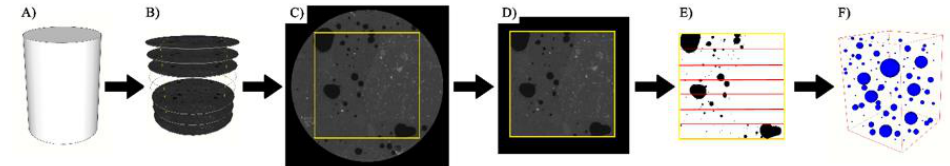
Figure 4. Approach 1: Downsized linear traversed method (2D). ( A ) Extracted core from larger beam, ( B ) Selected images 1 mm apart throughout an entire core specimen, ( C , D ) Inscribed square with maximum dimensions within the circle, ( E ) Binary image with applied threshold and traverse lines, and ( F ) square prism as final